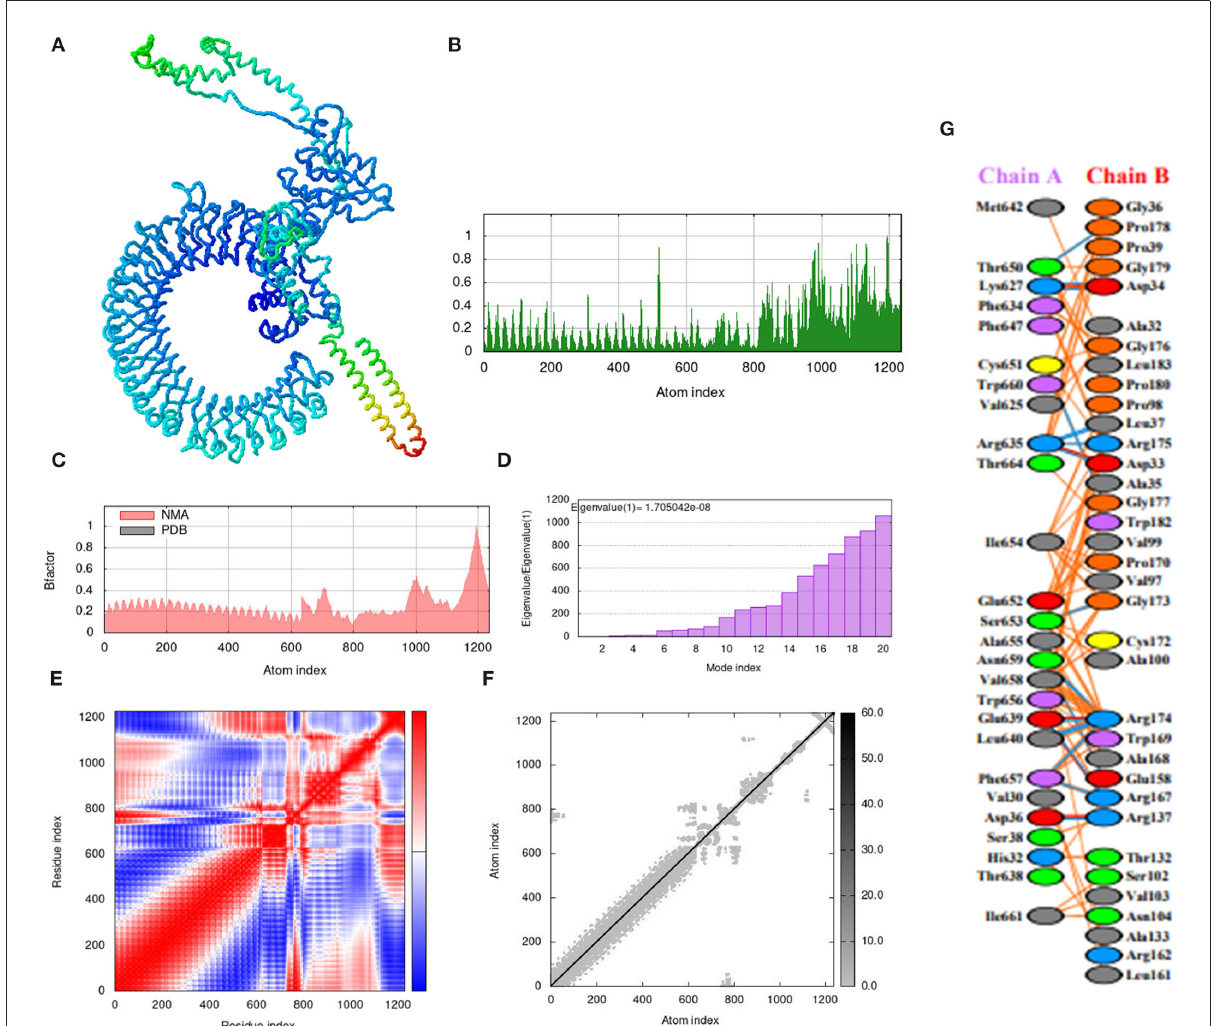
FIGURE10 Molecular dynamics simulation, NMA, and receptor–ligand interactions: (A) vaccine-TLR-4 docked complex using the Cluspro server, (B) deformability graph, (C) eigenvalue of the vaccine-TLR-4 complex, (D) B-factor graph, (E) covariance matrix, (F) elastic network model using the iMOD server, (G) receptor–ligand interaction using the PDBsum web